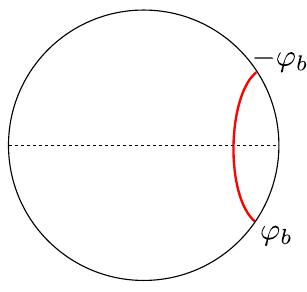
Figure 6 . Inserting an operator in Euclidean time creates a particle at